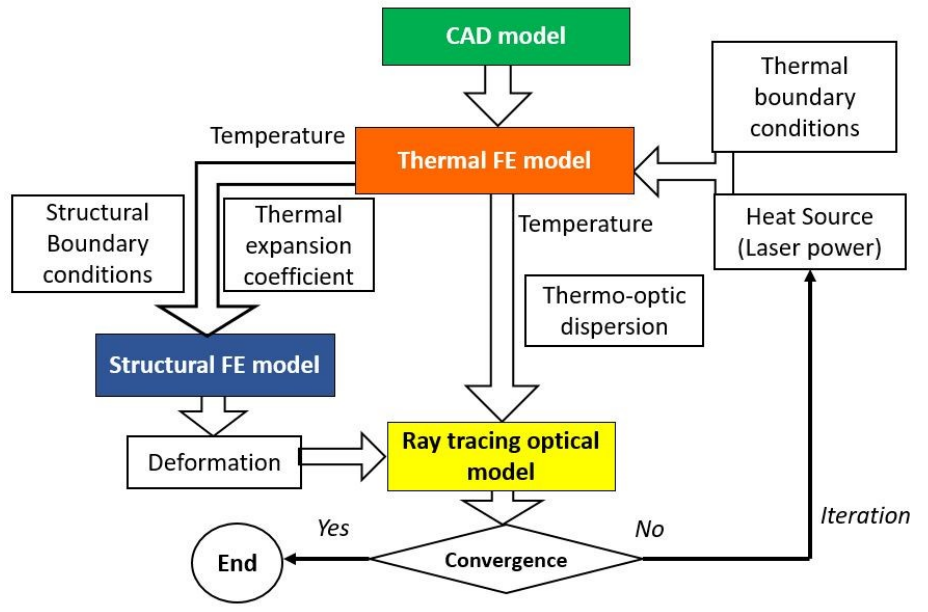
Figure 4. The flowchart of the STOP analysis for the optical laser head.